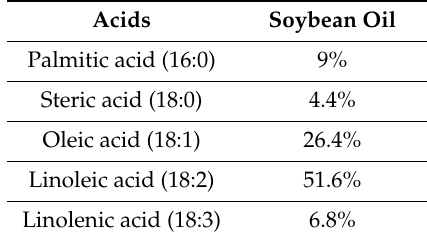
Table 5. The composition of soybean oil